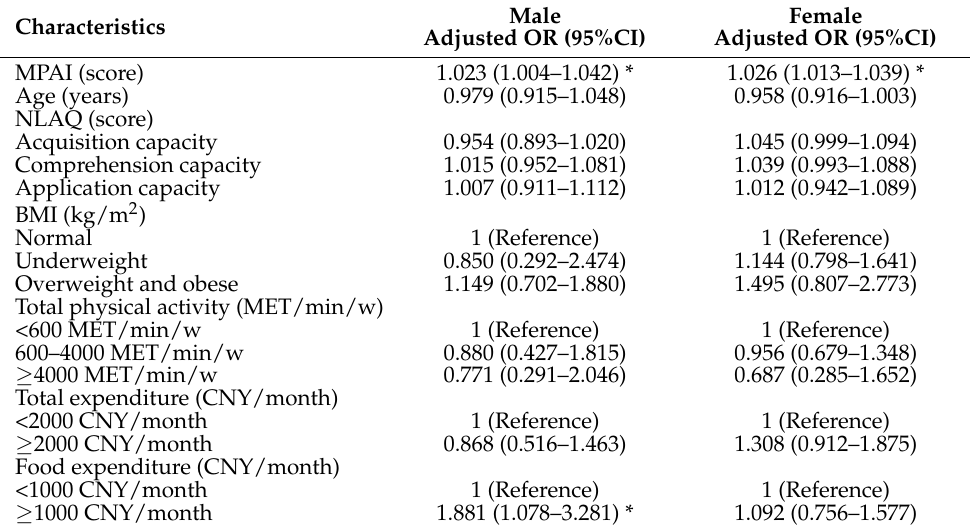
Table 2. Multivariate logistic model to explore MPAI and other potential factors that may influence carbonated beverages intake stratified by